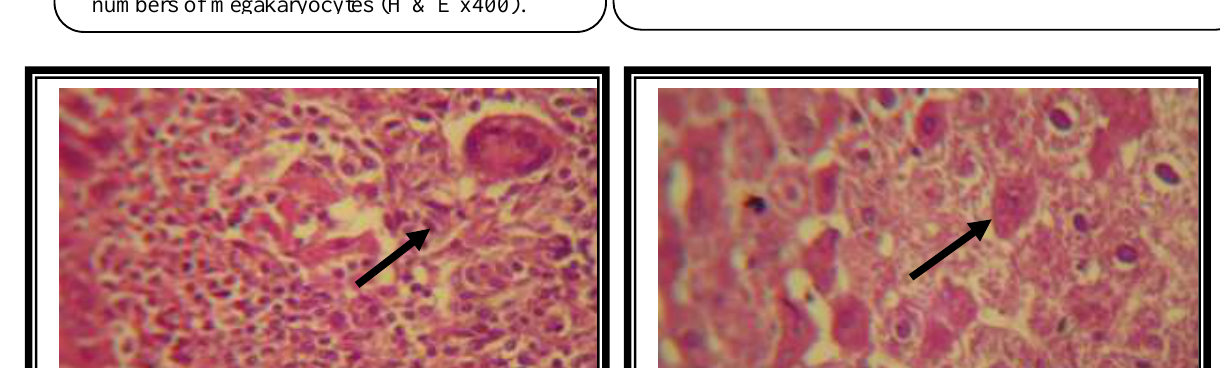
Fig(11) :Histopathological section of Intestine treated with ethanolic extract of grape seed at dose (200mg/kg b.w orally) showing infiltration of mononuclear cells in mucosa with slight fibrosis leading to atrophy of glands (H & E x400).